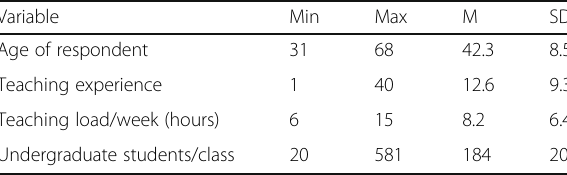
Table 1 Socioeconomic characteristics of respondents Table 2 Descriptive statistics of respondents ’